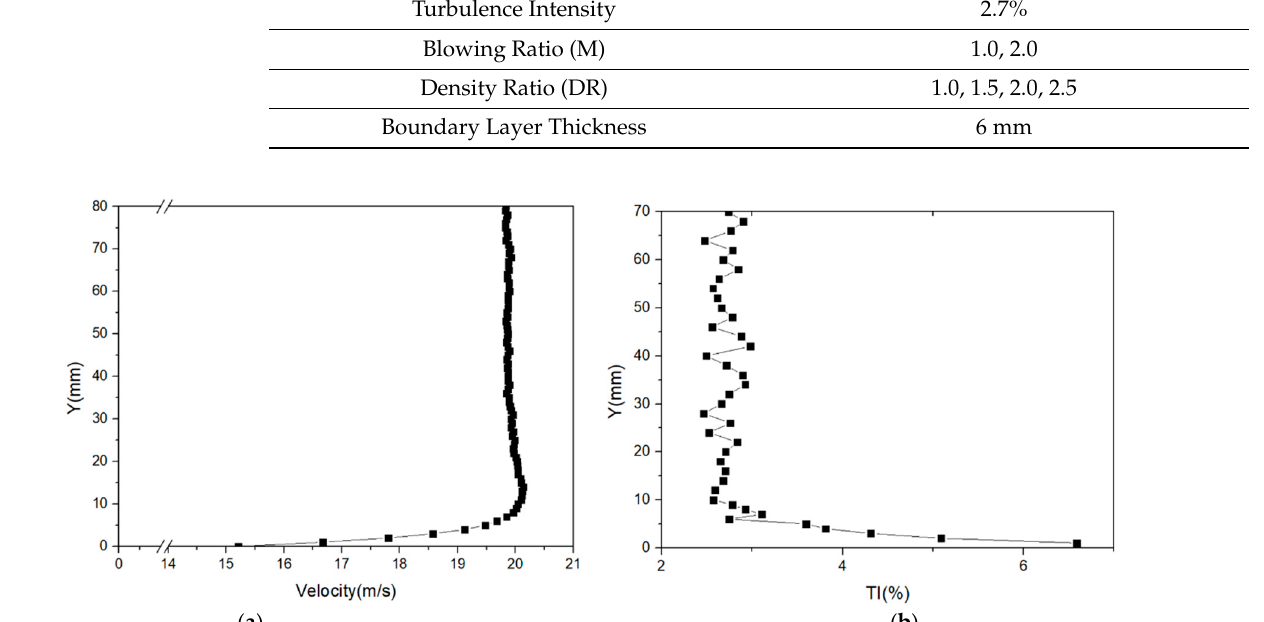
Figure 5. Distribution of flow field characteristics: ( a ) velocity; and ( b ) turbulence intensity.